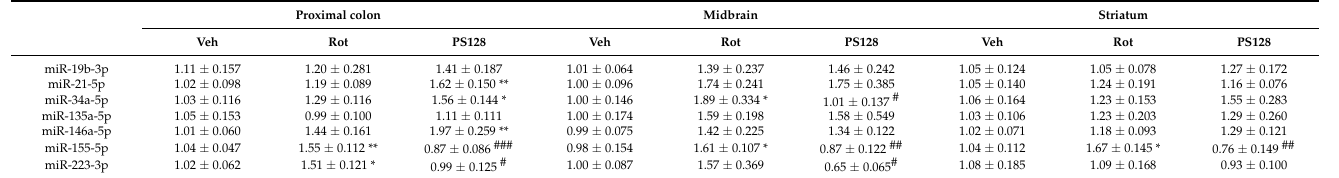
Table 1. Effects of L. plantarum PS128 on the levels of microRNA (miRNA) expression in different tissues. Proximalcolon Midbrain